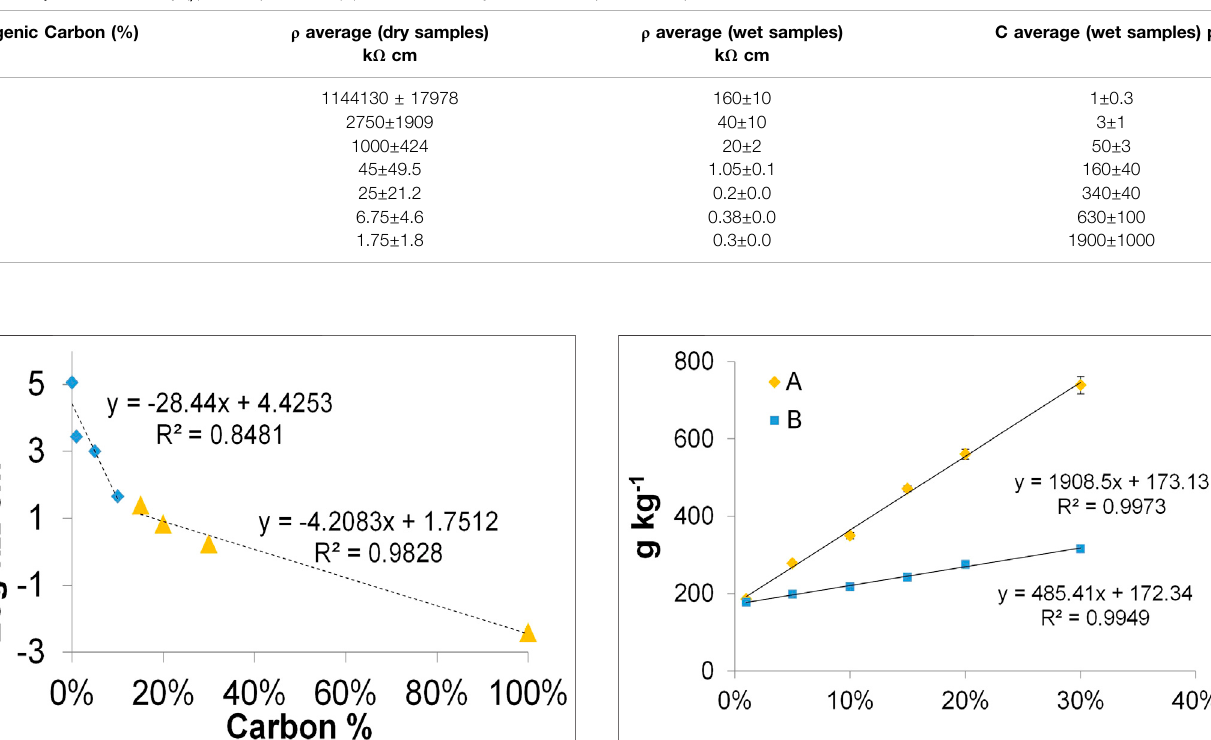
FIGURE6| GraphicsofwaterretentionforsamplesofcompositeAandB.